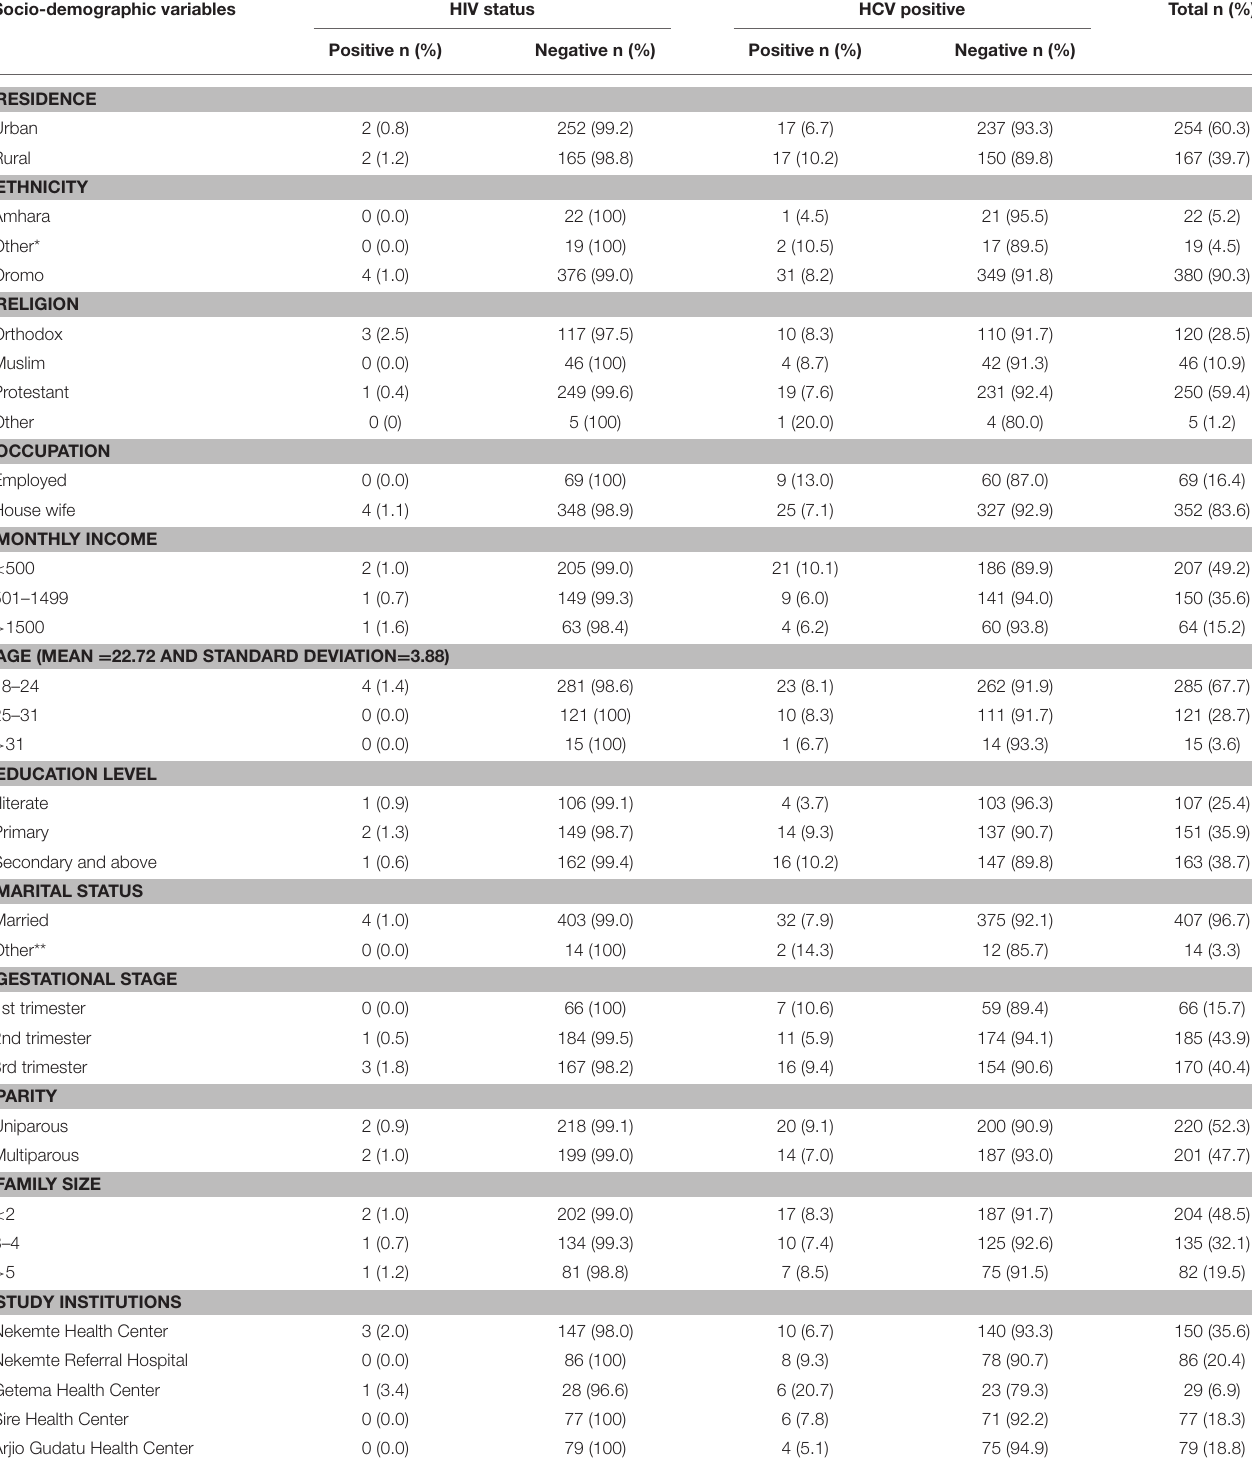
TABLE 1 | Prevalence of HIV and HCV among pregnant women attending antenatal care at East Wollega Administrative Zones, Ethiopian, 2014 ( n = 421). Socio-demographic